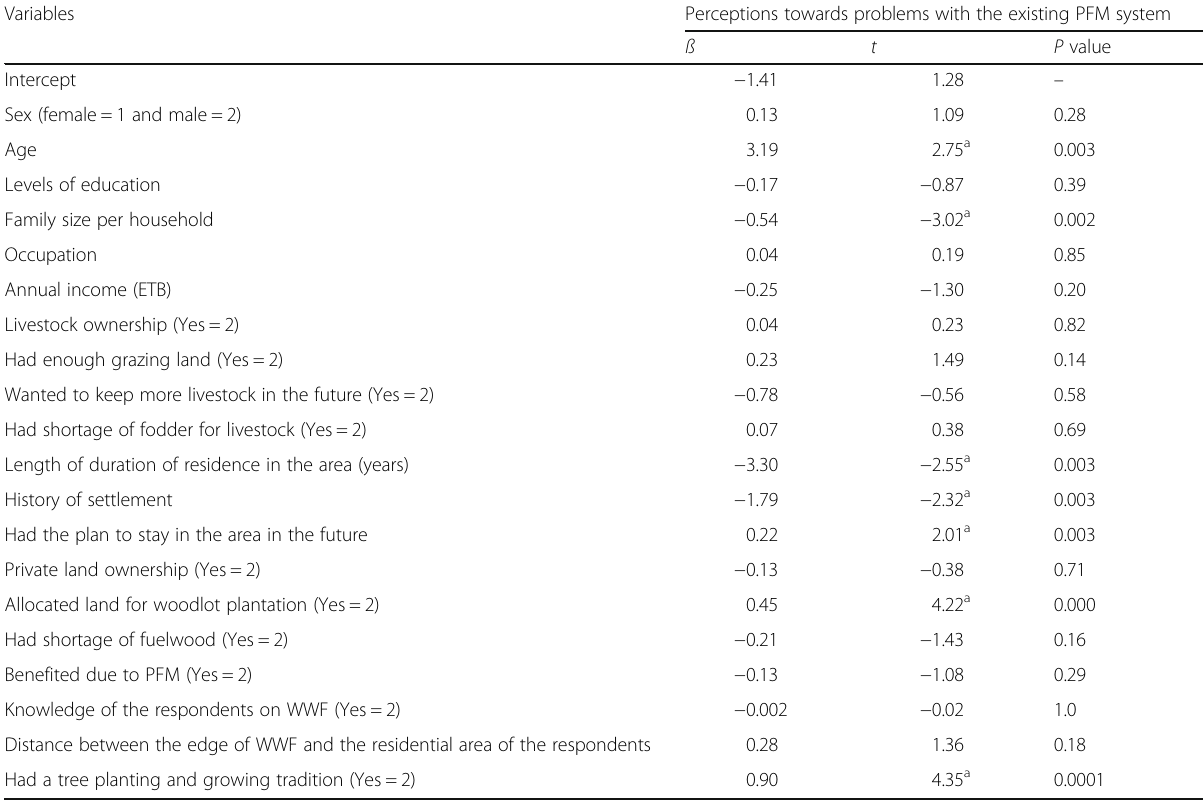
Table 4 Multiple linear regression model (standardized coefficients were reported) to predict the perceptions of local people towards the prevalence of problems with the existing PFM system in WWF ( R 2 = 0.586 (Adj. R 2 = 0.39), df = 19; F = 3.039, overall P < 0.001) (+ = a positive change in perceptions and − = a negative change in